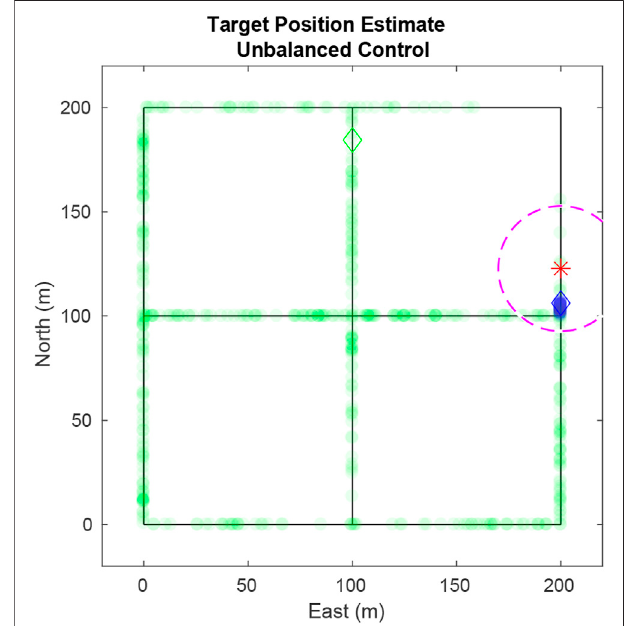
FIGURE2| Using the naïvevaluefunction in Eq. 17 , theUAVexclusively tracks a single target because of the closely packed particles of that target. Ideally the UAV should weight the target with highest entropy more heavily. Particles are plotted as transparent dots to indicate density. The diamonds shows true target positions, the star shows the UAV position, and the dashed circle delineates the UAV ’ s fi eld-of-view F One target is represented in blue while the other is